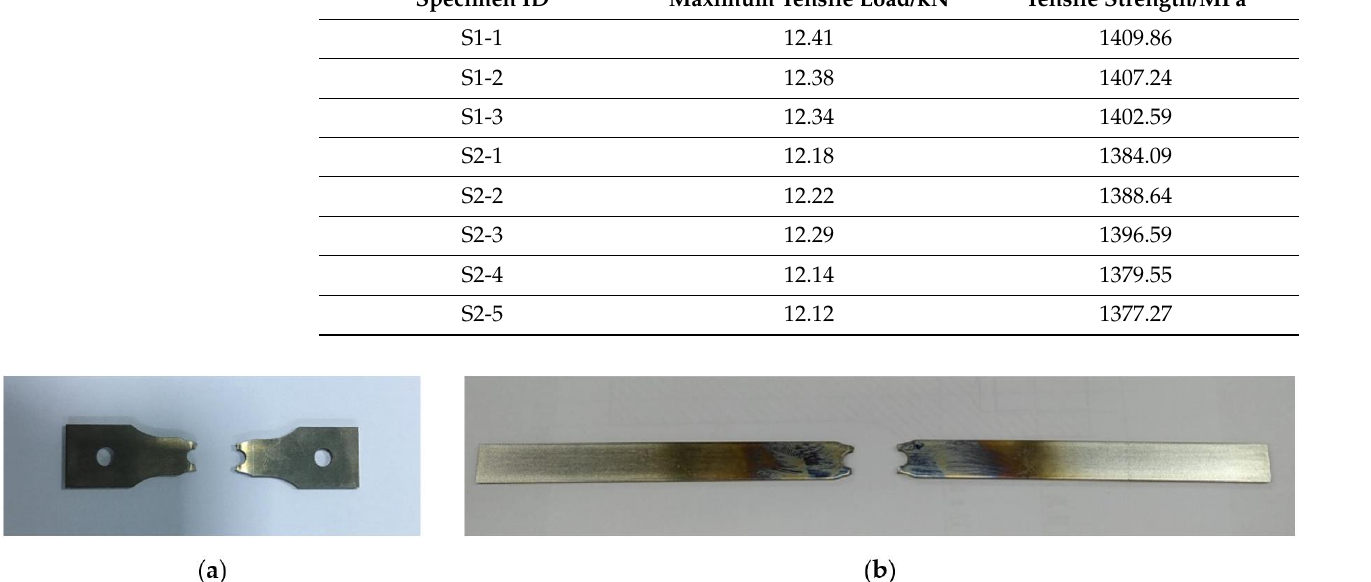
Table 3. The test data.